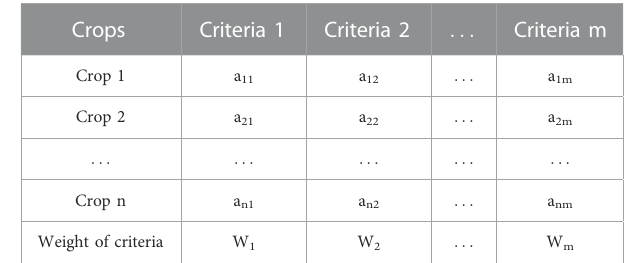
TABLE 1 The performance matrix of TOPSIS